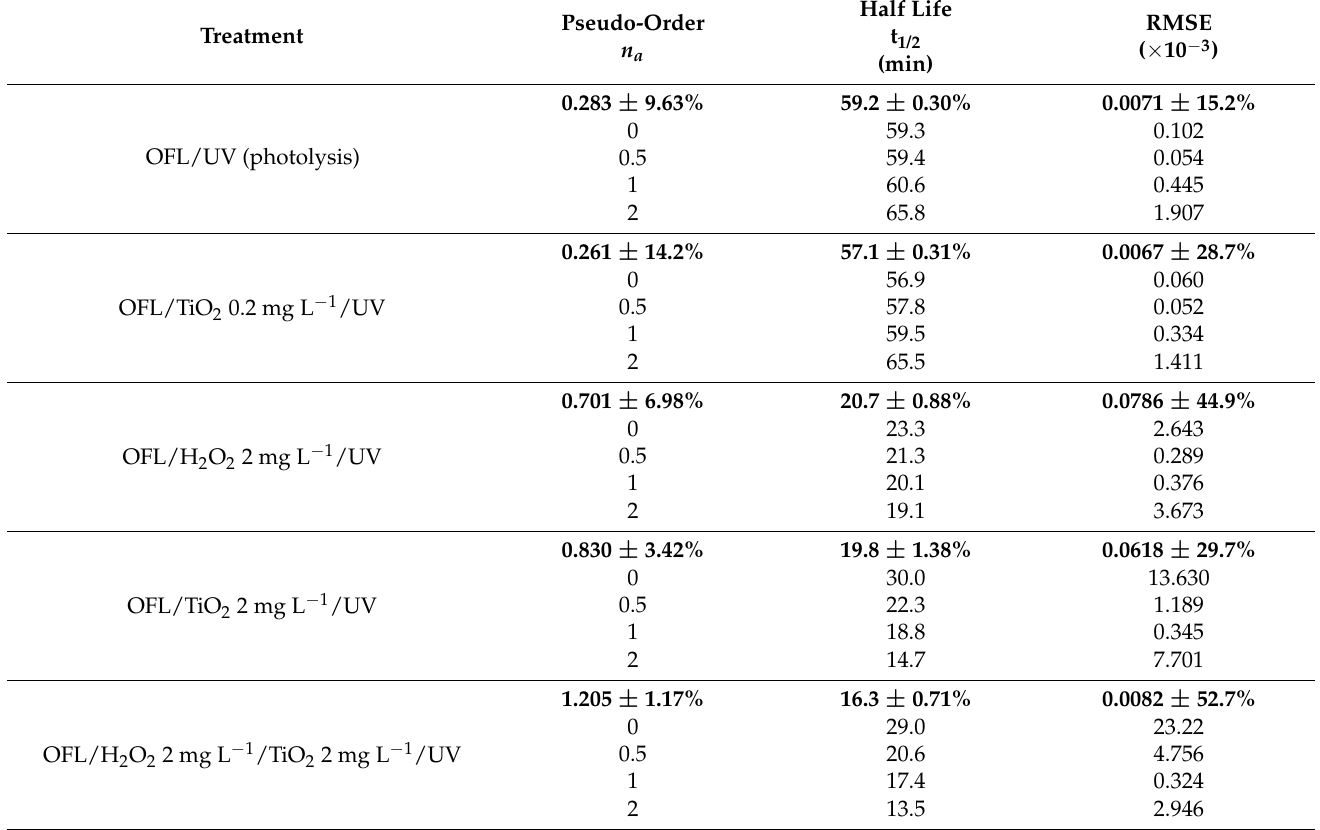
Table 1. Pseudo-orders, half-life times and root mean square errors for all the experiments. The first row in each treatment (in bold ) represents the best fit, with errors calculated by bootstrap procedure. Half Life RMSE Pseudo-Order t 1/2 Treatment n a ( × 10 − 3 (min)